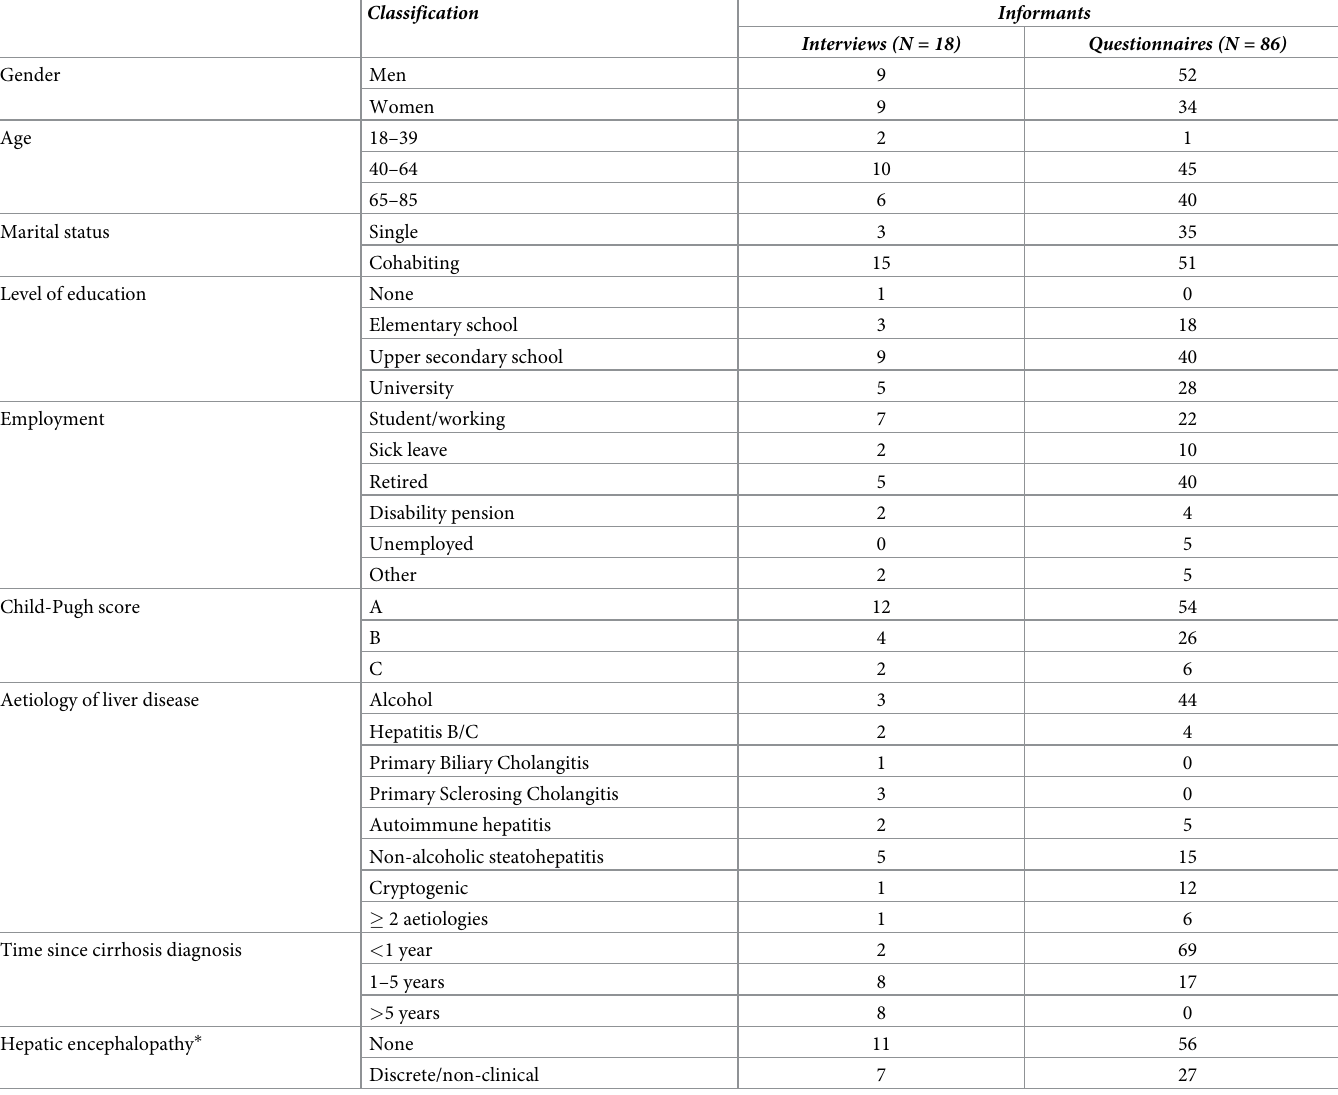
Table 1. Characteristics of informants from interviews and